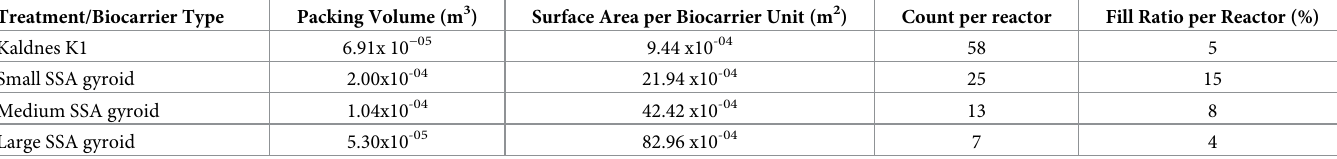
Table 3. Parameters for Experiment 2 with constant total biocarrier surface area (0.055 m 2 ). Treatment/Biocarrier Type